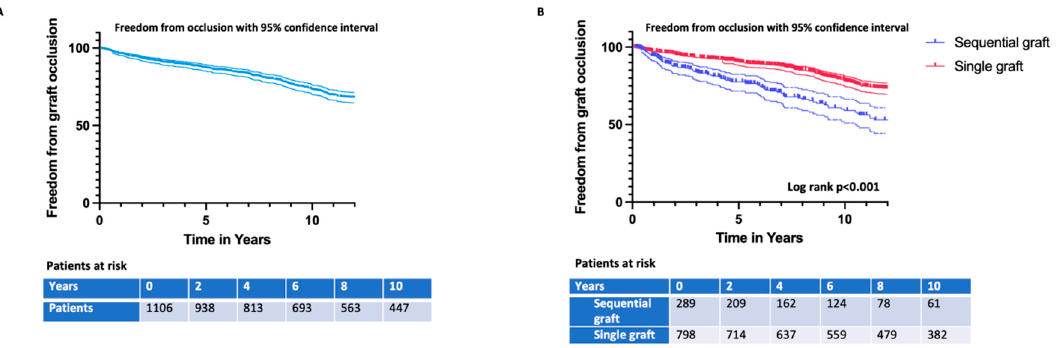
Figure 2. ( A ): Overall freedom from graft occlusion. ( B ): Freedom from graft occlusion for different graft types: single conduit and sequential conduit.